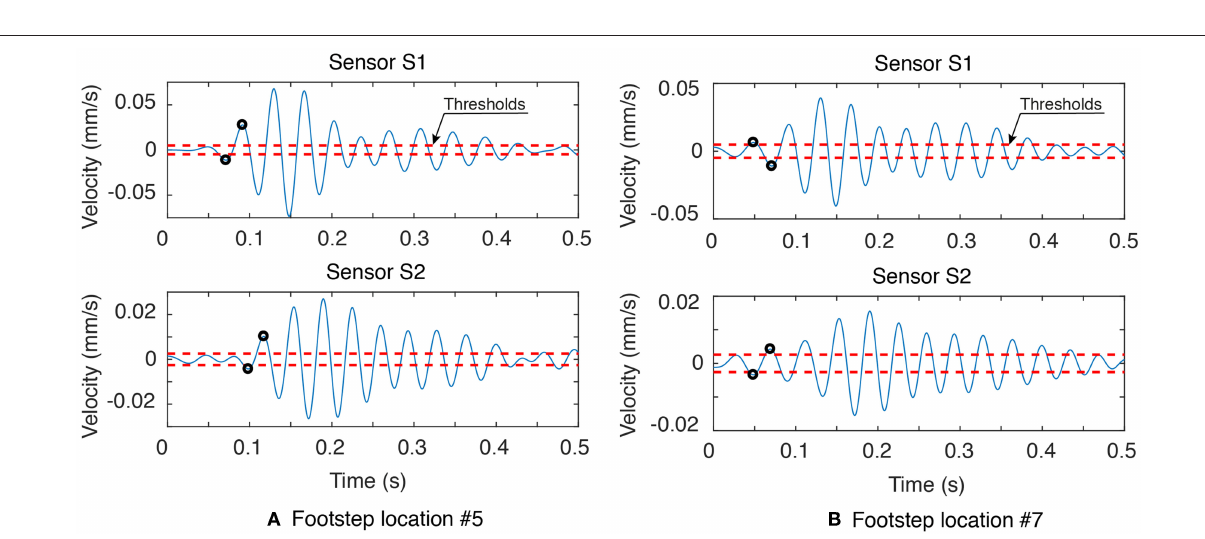
footstep events #5 and #7, time corresponding to exceedance of thresholds in graphs (a) and (b) are not correlated with the distance between sensor positions and footstep impact